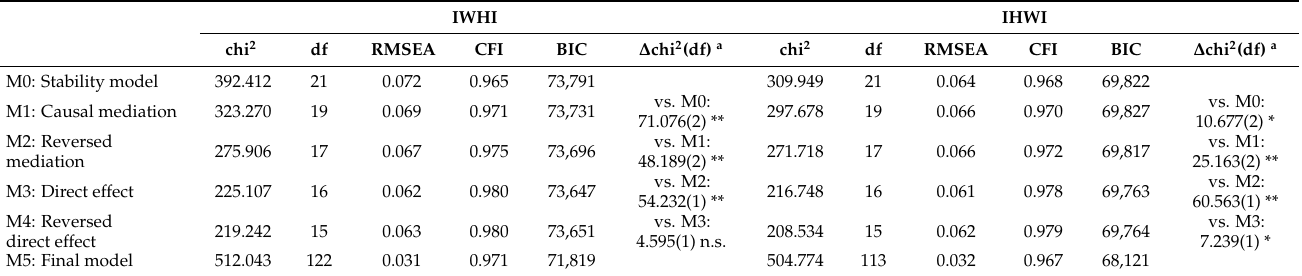
Table 2. Fit indexes and model comparisons for WTC, IWHI/IHWI, and exhaustion ( n = 3341–3390).